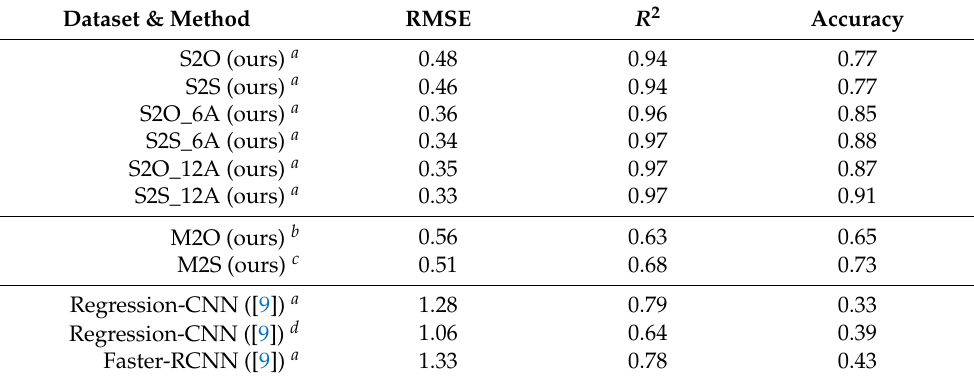
Table 3. Performance comparison between our and existing methods on M2 and S2.